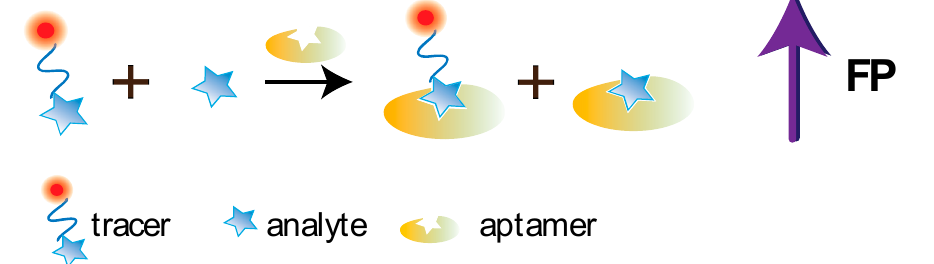
Figure 6. Principle of aptamer-based FPA.